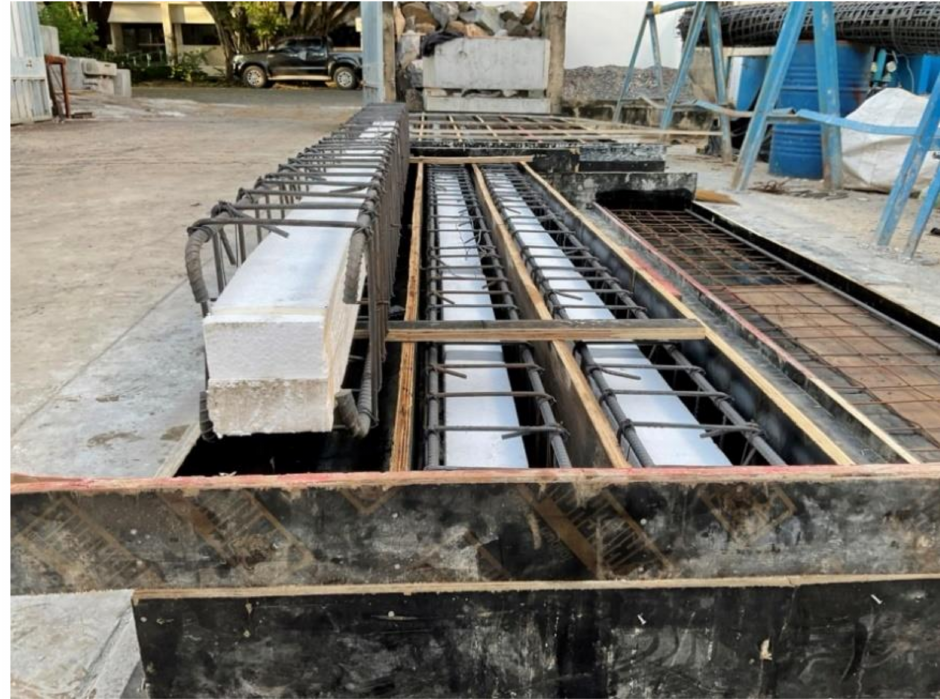
Figure 4. Installation of foam in steel bars.